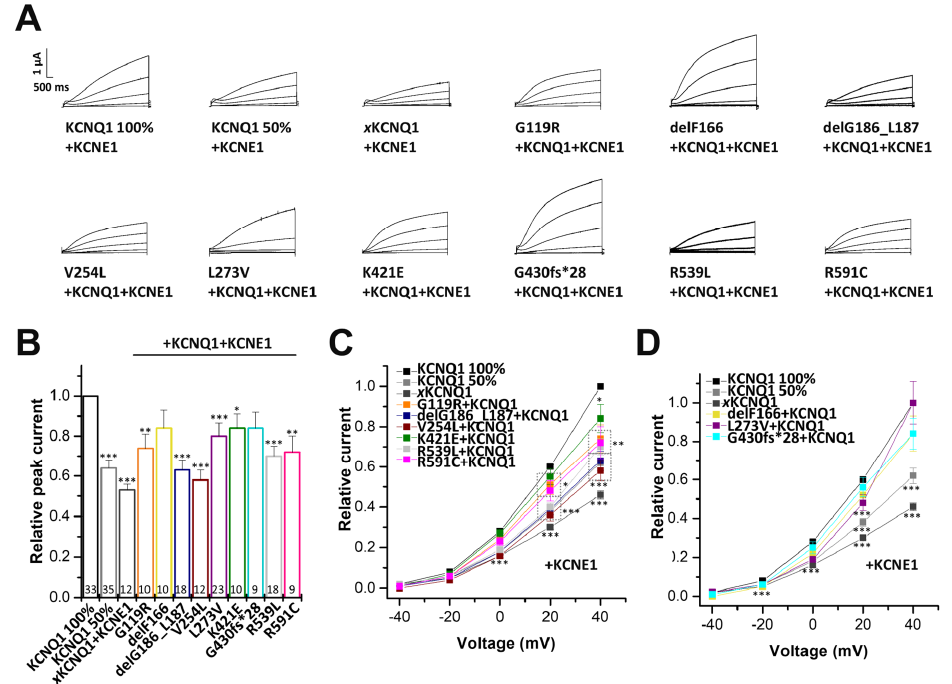
Figure 6. Electrophysiological properties of KCNQ1 variants co-expressed with wild-type KCNQ1 and KCNE1. ( A ) Xenopus laevis oocytes were injected with different controls. KCNQ1 100% = 81.2 ng wild-type cRNA, plus 1 ng KCNE1; KCNQ1 50% = 40.6 ng wild-type KCNQ1 cRNA and 1 ng KCNE1. The heterozygous KCNQ1 variants were studied by injecting 40.6 ng cRNA of the respective variants plus 40.6 ng wild-type KCNQ1 cRNA, together with 1 ng of KCNE1 cRNA. In addition, oocytes were injected with 1 ng of KCNE1 alone, to quantify the endogenous xI Ks formed by co-assembly of KCNE1 with endogenous x KCNQ1. Voltage was stepped for 7s to potentials ranging from − 40 to +40 mV in +20 mV increments. The holding potential was − 80 mV. Representative current traces of the indicated constructs are shown. ( B ) Current amplitudes were analyzed at +40 mV and normalized to 100% KCNQ1 wild-type, plus KCNE1. All the data, including that of wild-type recordings, were divided by the average current amplitude of the wild-type at +40 mV of the respective recording day. Numbers of oocytes are indicated within the bar graph. Currents of the L273V variant were analyzed at +20 mV, as the effects of this variant were voltage-dependent, but clearly present in the physiological range. ( C ) Heterozygous variants with significantly reduced current amplitudes compared to KCNQ1 WT 100% + KCNE1. ( D ) Heterozygous variants with no significant changes in current amplitudes. Note that for the L273V variant studied in the heterozygous state, in the presence of KCNE1, significant current reductions are observed at membrane potentials lower than +40 mV. Values are expressed as means ± S.E.M.. Error bars represent S.E.M. values. Significance was assessed using two tailed Student’s t -test. Asterisks indicate significance: *, p < 0.05; **, p < 0.01; ***, and p <